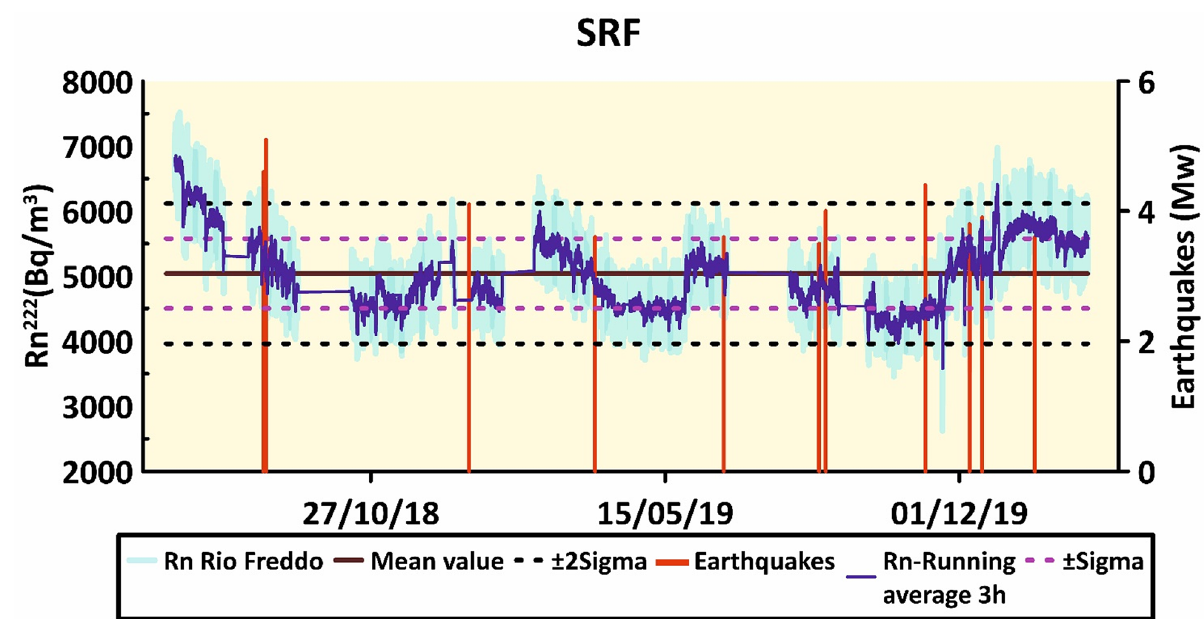
and with dashed ones, respectively. Seismic events with M (from the INGV database, available online at http://terre moti.ingv. it/) are shown with red